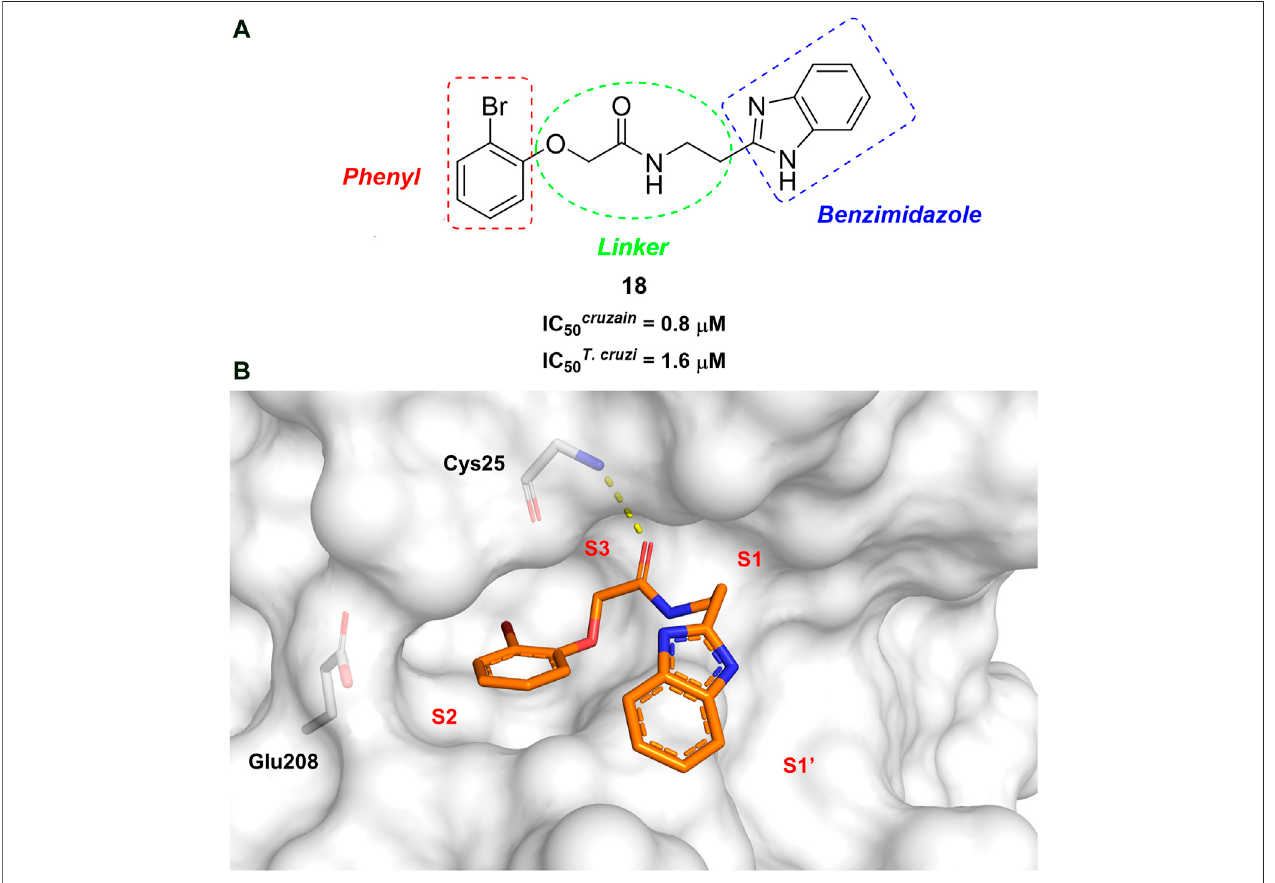
FIGURE 1 | (A) Cruzain inhibitor 18 was used as the lead compound for the design of novel benzimidazole derivatives. (B) X-ray structure of compound 18 in complexwithcruzain(PDB3KKU,1.28 Å).Bindingsiteresidues(carboningray)andcompound 18 (carboninorange)areshownassticks.Ahydrogenbondisshownas a dashed line. Cruzain subsites are labeled as S1, S1 ′ , S2, and S3.